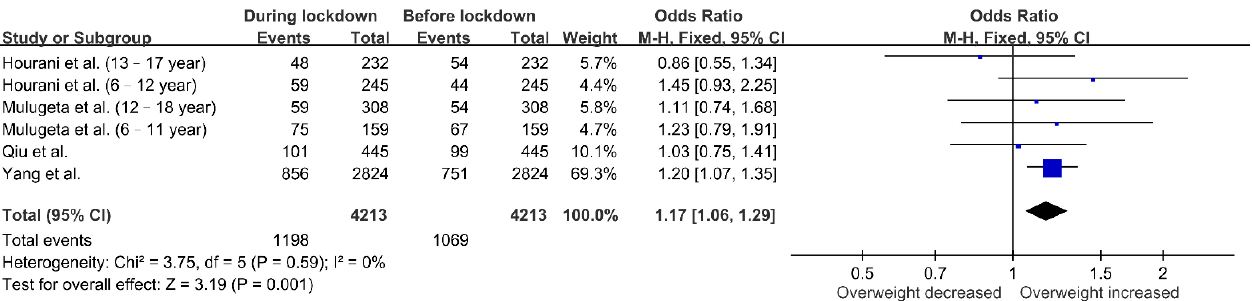
Figure 4. Associations between lockdown and obesity in children. The obesity rate increased during lockdown.